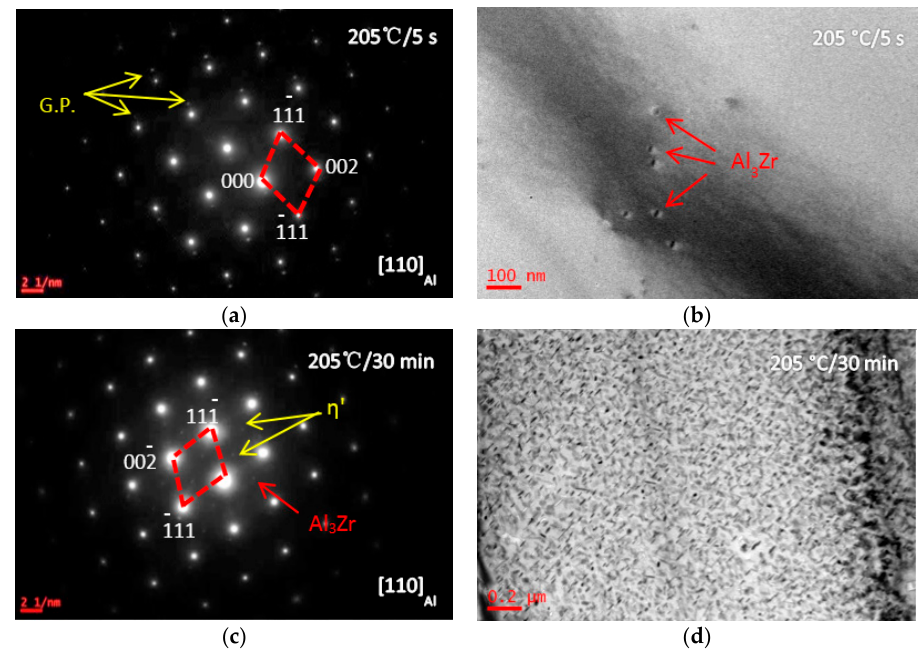
Figure 3. SADPs and BF images of the specimens having been isothermal heat treated at 205 °C for different durations (5 s and 30 min). ( a ) SADP of (b), beam along [110] Al ; ( b ) the IHT time is 5 s; ( c ) SADP of (d), beam along [110] Al ; and( d ) the isothermal heat treatment (IHT) time is 30 min.